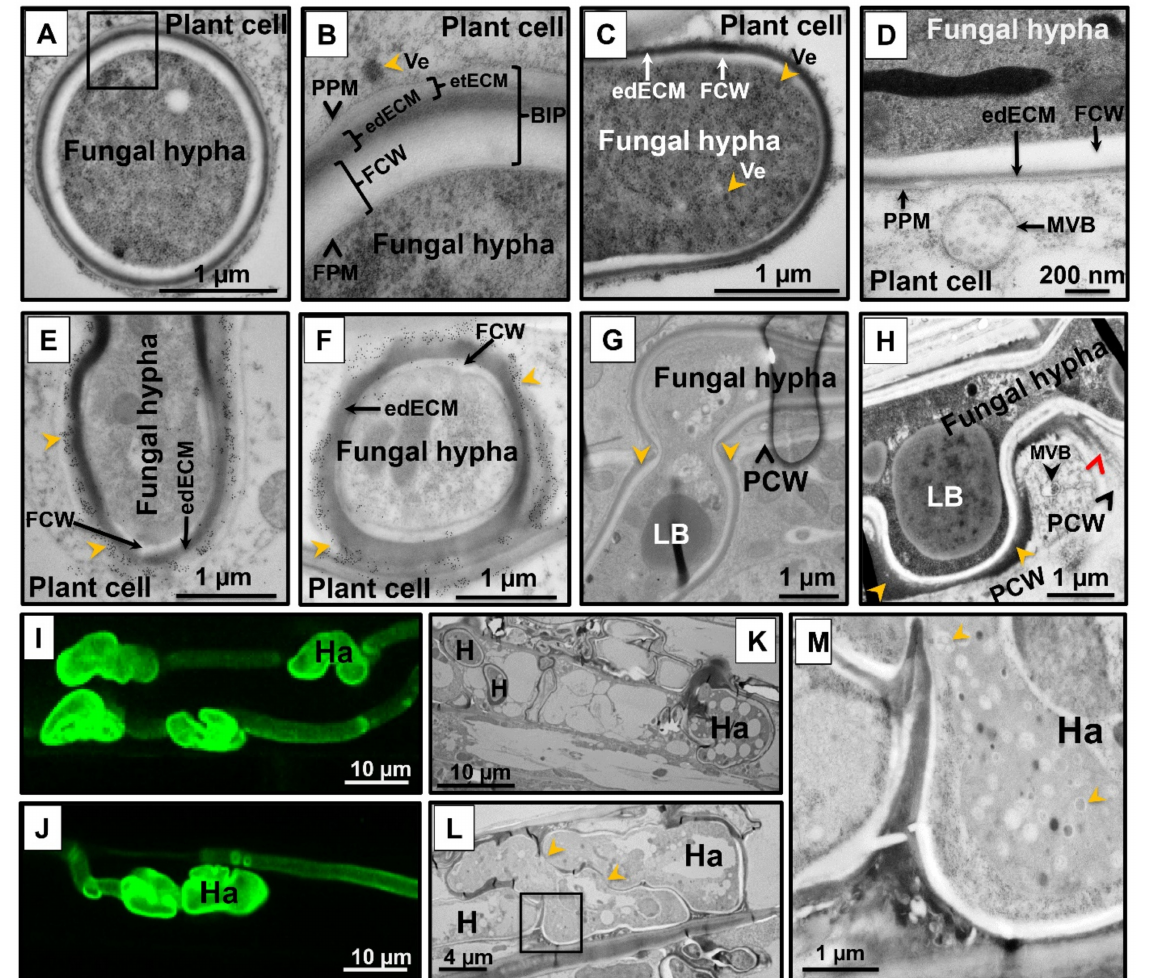
Figure 2. ( A – H ) Transmission electron microscopy micrographs of wild-type Ustilago hordei -infected barley leaves. ( A , B ) Biotrophic interphase in the U. hordei –barley interaction. During host colonization, U. hordei invaginates the host cell membrane without breaching it. The host–pathogen interaction mainly takes place within this biotrophic interphase (BIP), which consists of the fungal cell wall (FCW), electron-dense extracellular matrix (edECM), and electron-translucent extracellular matrix (etECM). ( C , D ) Formation of vesicles at the hyphal tip of U. hordei . Fungal vesicles (Ve) with cores of different electron densities and plant multivesicular bodies (MVB) were detected at hyphal tips and in the plant cytoplasm close to fungal penetration sites, respectively. ( E , F ) Immunogold labeling of callose with a monoclonal antibody recognizing (1-3)- β -glucan epitopes. Callose accumulation was detected at the electron-translucent ECM (etECM) site (yellow arrowheads). ( G , H ) Cell-to-cell penetration of U. hordei . U. hordei primarily grows intracellularly at 8 dpi in barley leaves. When the fungal hyphae penetrate a new plant cell, the hypha gets thickened at the site of cell-to-cell passage, resembling appressorial structures ( G ). The edECM gets thicker at the site of hypha contact with the plant cell wall (yellow arrowheads) ( H ), while electron-dense material can also diffuse into adjacent parts of the plant cell wall (red arrowhead) ( H ). ( I – M ) Haustoria formation during host colonization. U. hordei grows intracellularly and forms haustorial structures in barley cells. ( I , J ) Wheat germ agglutinin (WGA)-AF488/propidium iodide (PI) staining was performed to visualize U. hordei at 8 days post inoculation (dpi) under confocal/fluorescent microscopy. ( K – M ) Transmission electron micrographs showing different planes of the section through haustoria. Haustorial structures were distinguished from hyphae by their bigger size and interconnected lobular shapes. Yellow arrowheads ( L ) point out the connections between haustorial lobes. U. hordei haustoria possess large vacuoles with a granular lumen containing vesicles of different sizes ( M ) (yellow arrowheads; magnification of inset in ( L )). BIP: biotrophic interphase; FCW: fungal cell wall; FPM: fungal plasma membrane; H: hypha; Ha: haustorium; edECM: electron-dense extracellular matrix; etECM: electron-translucent extracellular matrix; LB: lipid bodies; MVB: multi-vesicular body; PCW: plant cell wall; PPM: plant plasma membrane; Ve: